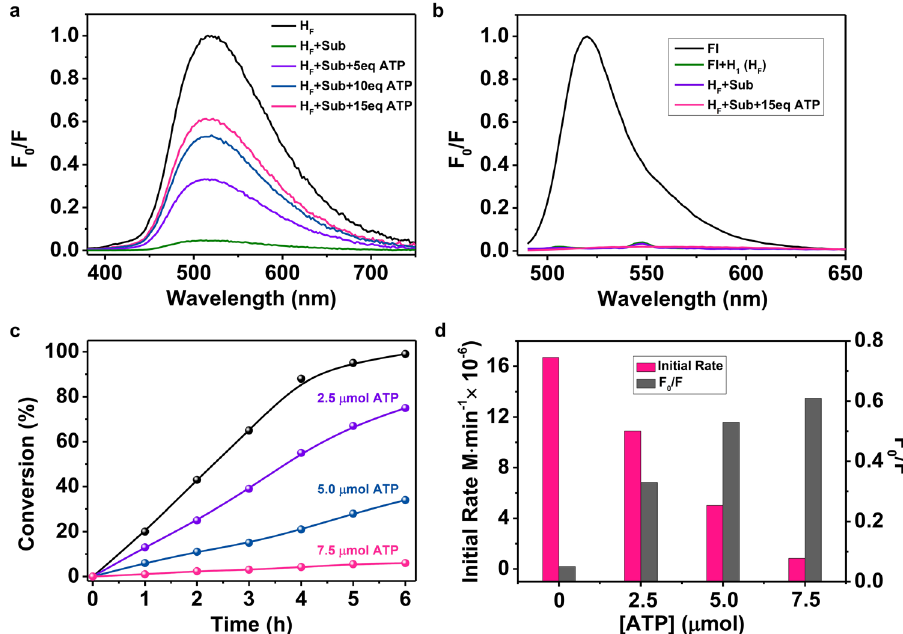
Fig. 6 The inhibition competing experiments of ATP. a , b Emission spectra of a CH 3 CN solution containing H F (20.0 μ M) and 9-nitroanthracene (0.75 mM) upon the addition of 0.1 mM, 0.2 mM and 0.3 mM ATP when excited at 365 nm or at 475 nm. c Conversion of 9-azoanthracene under standard conditions upon addition of 2.5 μ mol, 5.0 μ mol and 7.5 μ mol ATP. d The initial conversion rate of the azo product from 9-nitroanthracene under standard conditions and the recovery of capsule emission upon the addition of ATP at different